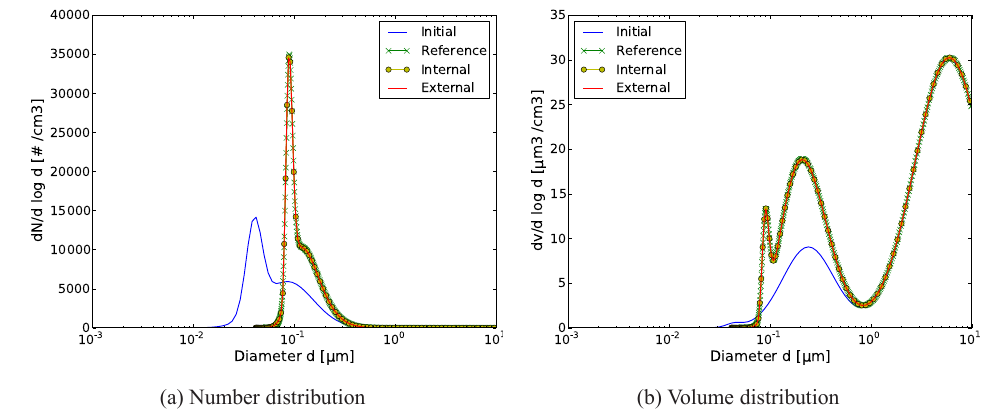
Figure 1. Simulation of condensation for hazy conditions: initial distribution and after 12h.